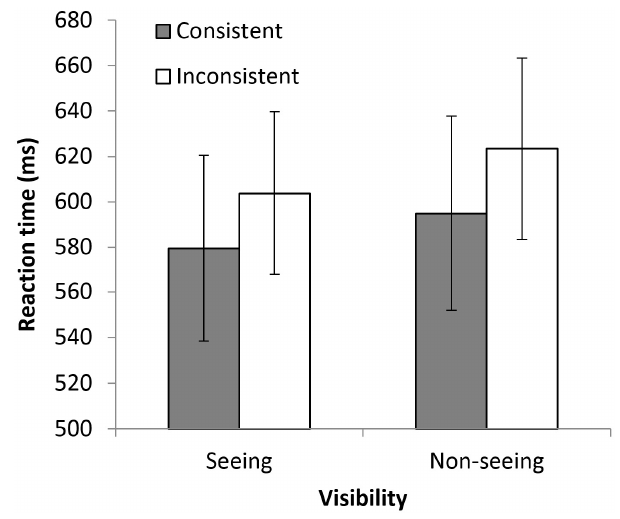
Figure 2. Mean RTs in each condition of Experiment 1. Error bars represent the standard error of the mean. Table 1. Percentage of errors and standard deviations (in parentheses) in each condition of Experiments 1 and